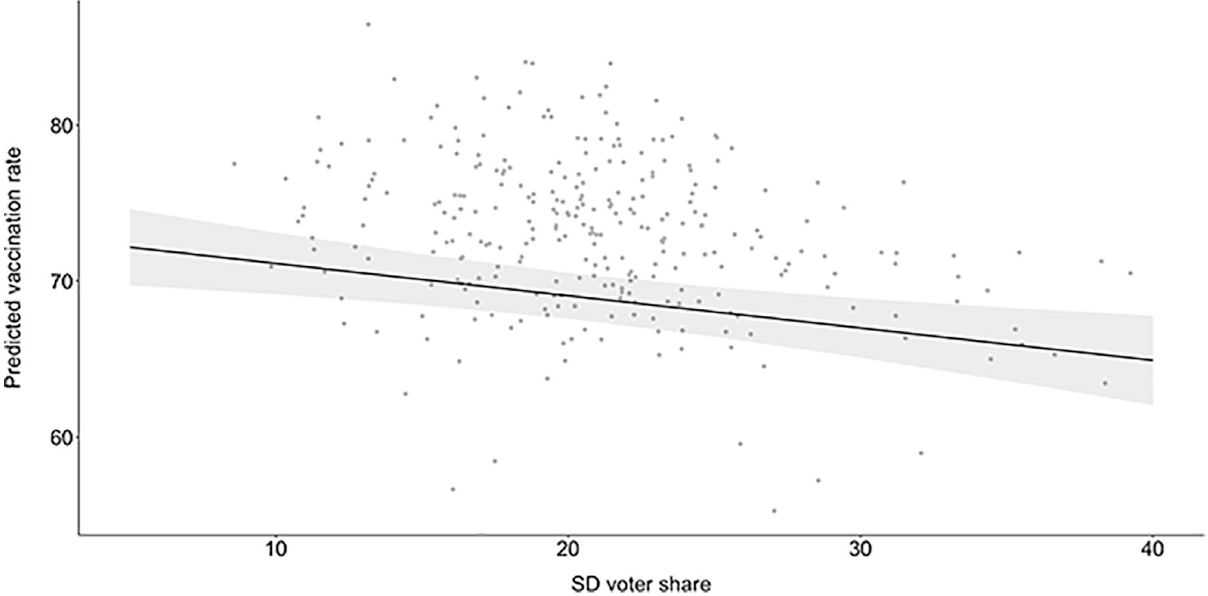
Fig 2. Predicted vaccination rates for municipalities with various levels of support for the SD. Gray dots are observed values.